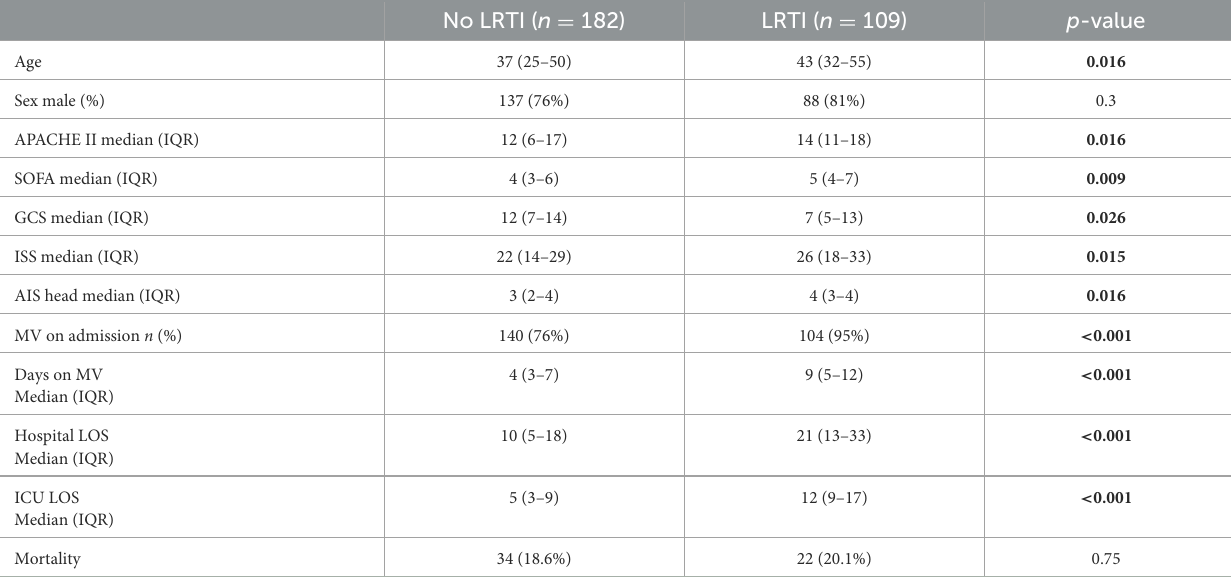
TABLE 2 Univariate comparison of baseline characteristics of TBI patients with and without LRTIs.